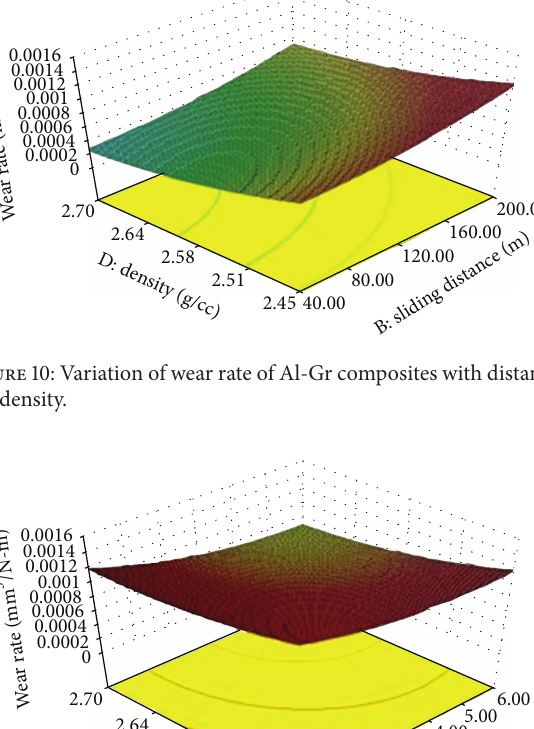
Table 2: Design matrix showing all experimental runs.